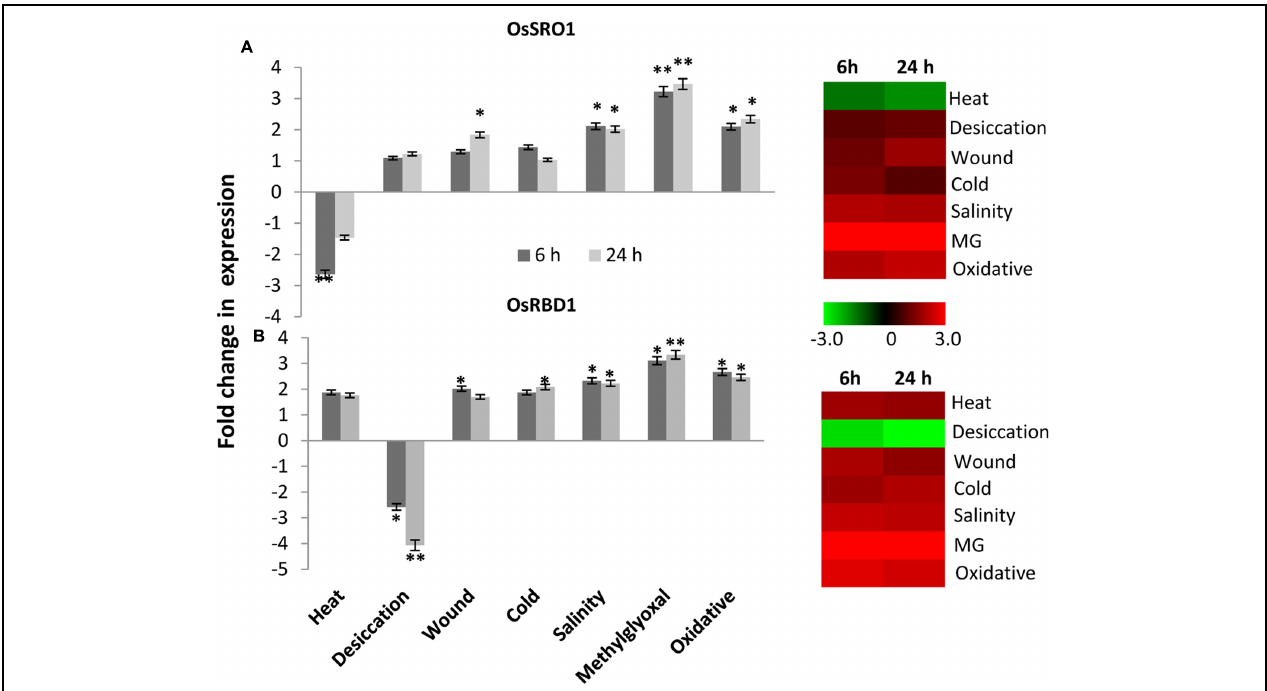
FIGURE 5 | Expression analysis of (A) OsSRO1a and (B) OsRBD1 in response to various abiotic stresses. Analysis was done using cDNA prepared from shoot tissues of 12 days-old seedlings at control conditions or seedlings subjected to heat (42 ◦ C), desiccation (air dry), wound (mechanical injury), cold (4 ◦ C), salinity (200 mM NaCl), methylglyoxal (5 mM MG) and oxidative stress (5 mM H 2 O 2 ) for 6 h and 24 h. Corresponding heatmaps were generated using TIGR MeV software package. Color bar represents relative expression values; thereby, green color represents lower expression levels, black represents no change, and red signifies higher expression level. Three replicates of each sample were used. Statistically significant change in transcript levels is indicated ( ∗ P < 0.05; ∗∗ P < 0.001).